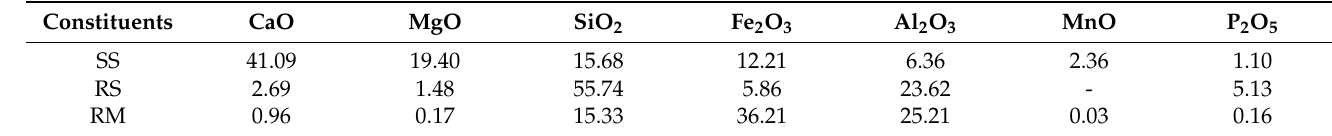
Table 1. Main inorganic chemical compositions of RS, SS, and RM (wt